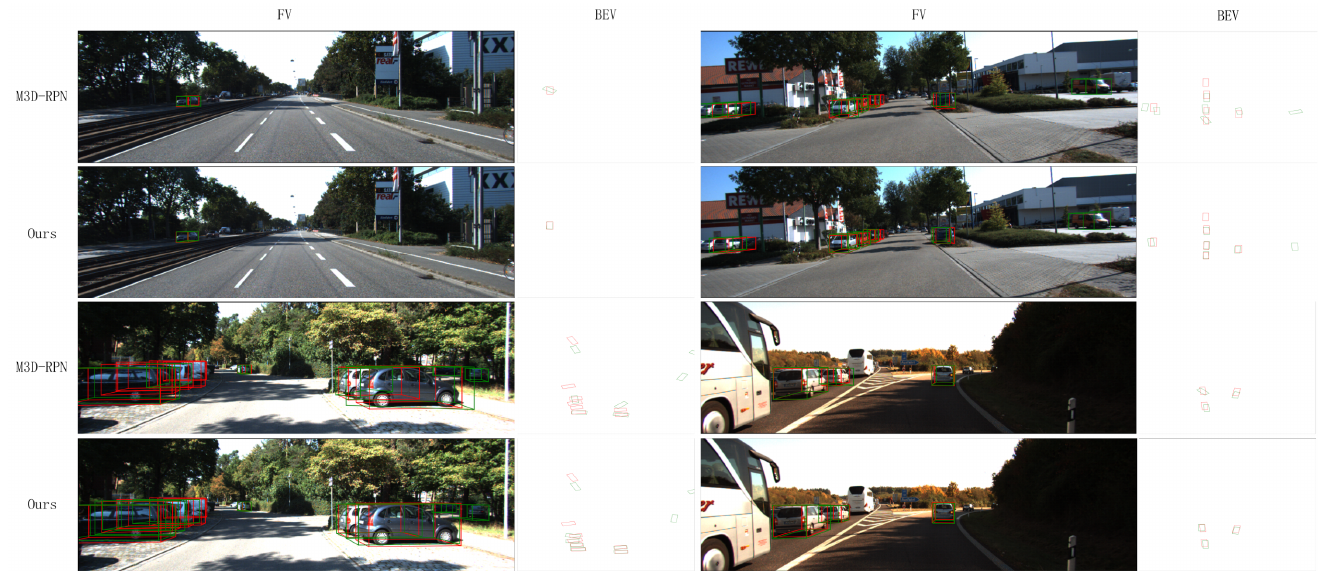
Figure 12. Qualitative results from our framework and MDSNet in the KITTI validation set. We use red box to denote the ground truth box and green box to denote the predicted box. It can be observed from the figure that our model has better accuracy for the prediction of depth and angle, and better performance for the detection of occluded objects.